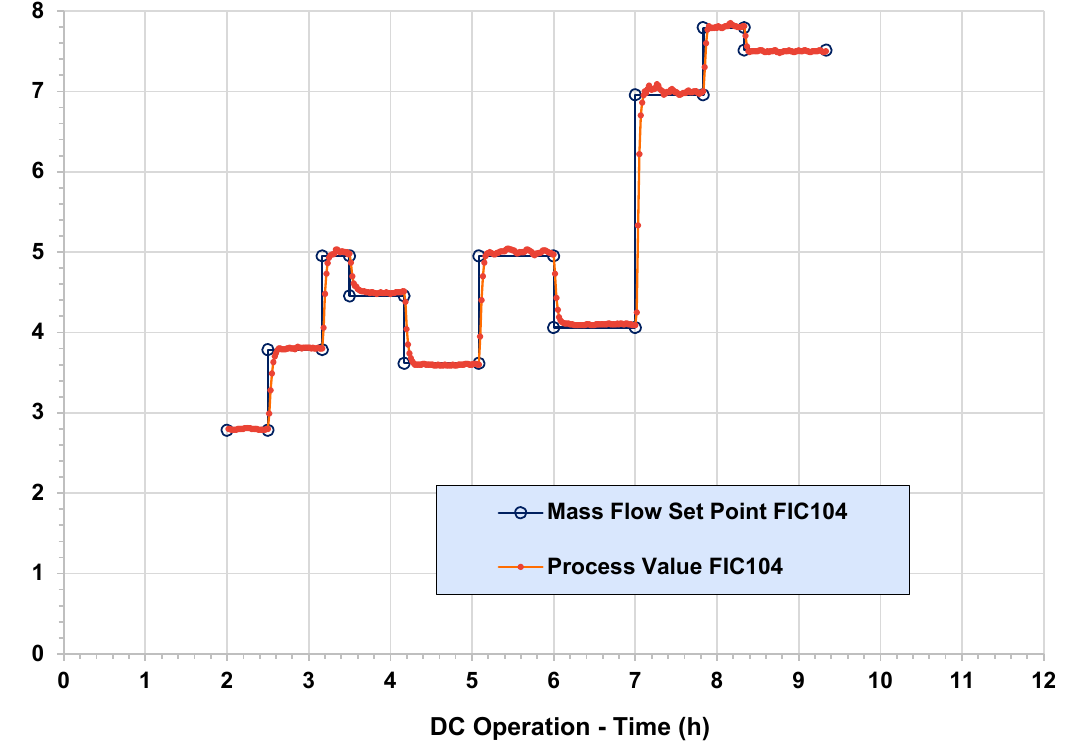
Figure 21. SC2. Mass flow set points versus time during test campaign of ALFE_CH3OH_PLP with DC.